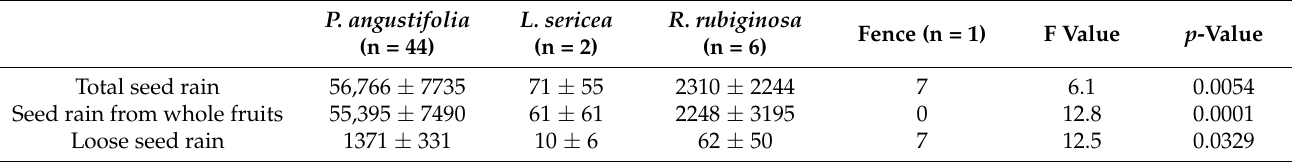
Table 2. Pyracantha angustifolia seed rain in seeds per square metre (mean ± SE) under P. angustifolia , Rosa rubiginosa, Leucosidea sericea, and fence lines. Densities of intact and loose seeds were analysed separately.